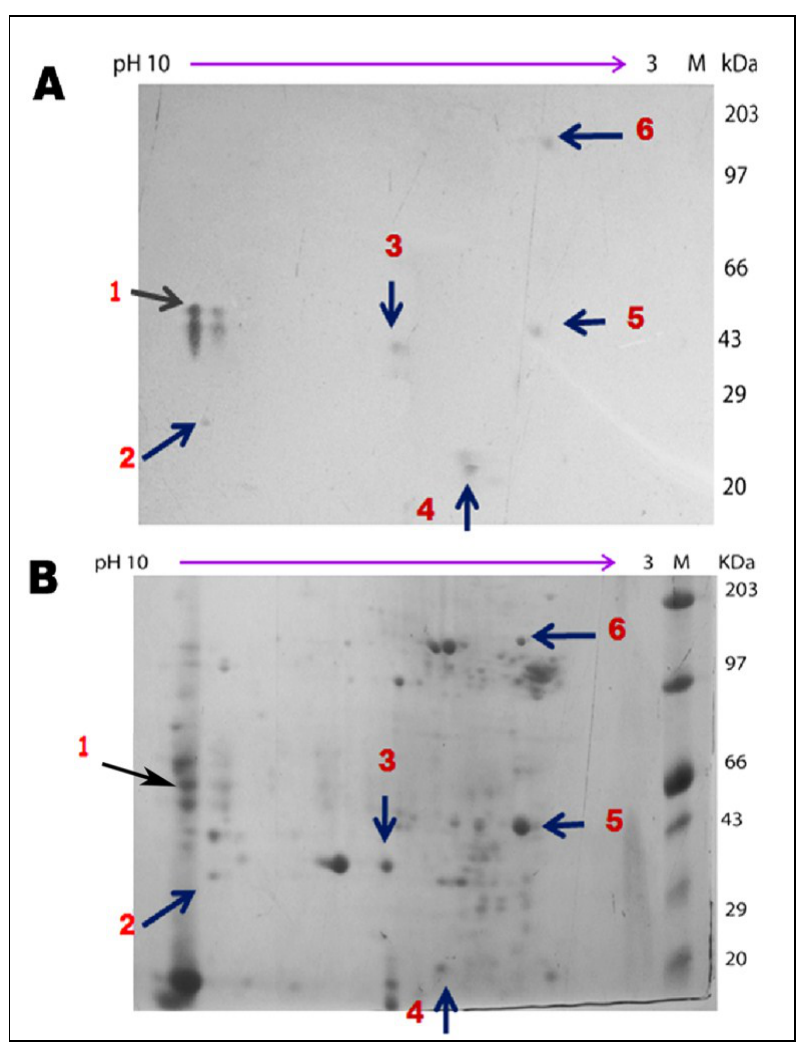
Figure 5. Ligand blot assay of total midgut protein fraction of RCB separated in 2D gel electrophoresis and subsequently challenged with CEA. ( A ) Ligand blot analysis of total midgut protein of RCB detected putative binding partners of CEA; ( B ) Total midgut protein of RCB stained with Coomassie (arrows indicated only those binding partners which were successfully identified in